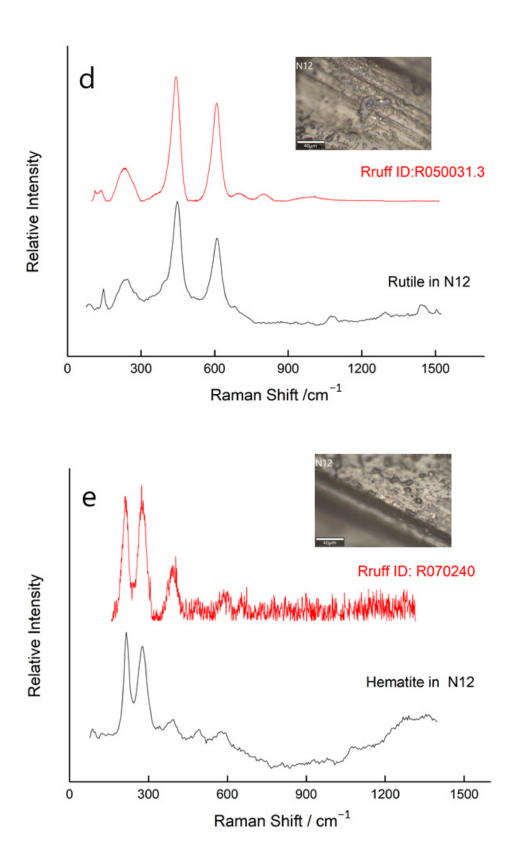
Figure 12. ( a ) Raman spectra of dolomite inclusions in tanzanite sample N5; ( b ) Raman spectra of molybdenite inclusions in tanzanite sample N8; ( c ) Micro-Raman spectra of prehnite inclusions in tanzanite sample N12; ( d ) Raman spectra of Rutile inclusions in tanzanite sample N12; ( e ) Raman spectra of hematite inclusions in tanzanite sample